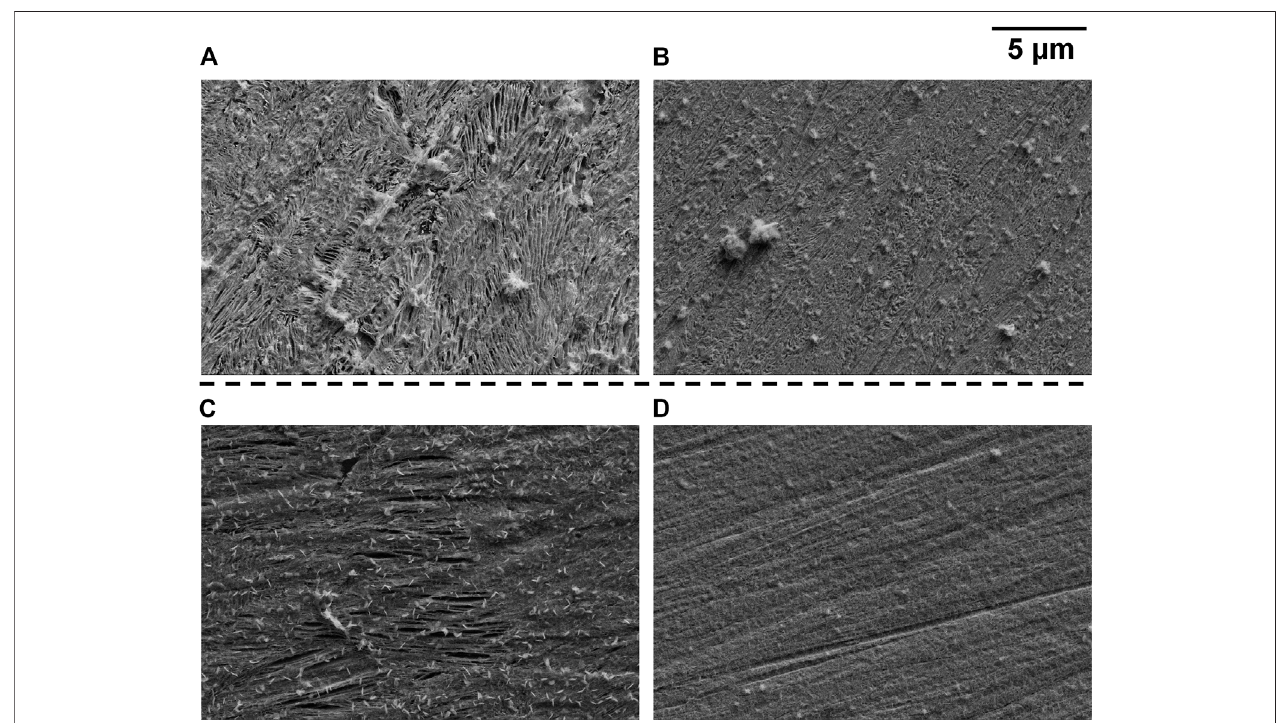
FIGURE 9 | SEM micrographs taken on samples after heat treatment with cooling rates 2 ° C/s [ (A) fully dissolved/dark area; (B) boundary area] and 5 ° C/s [ (C) fully dissolved/dark area; (D) boundary area].